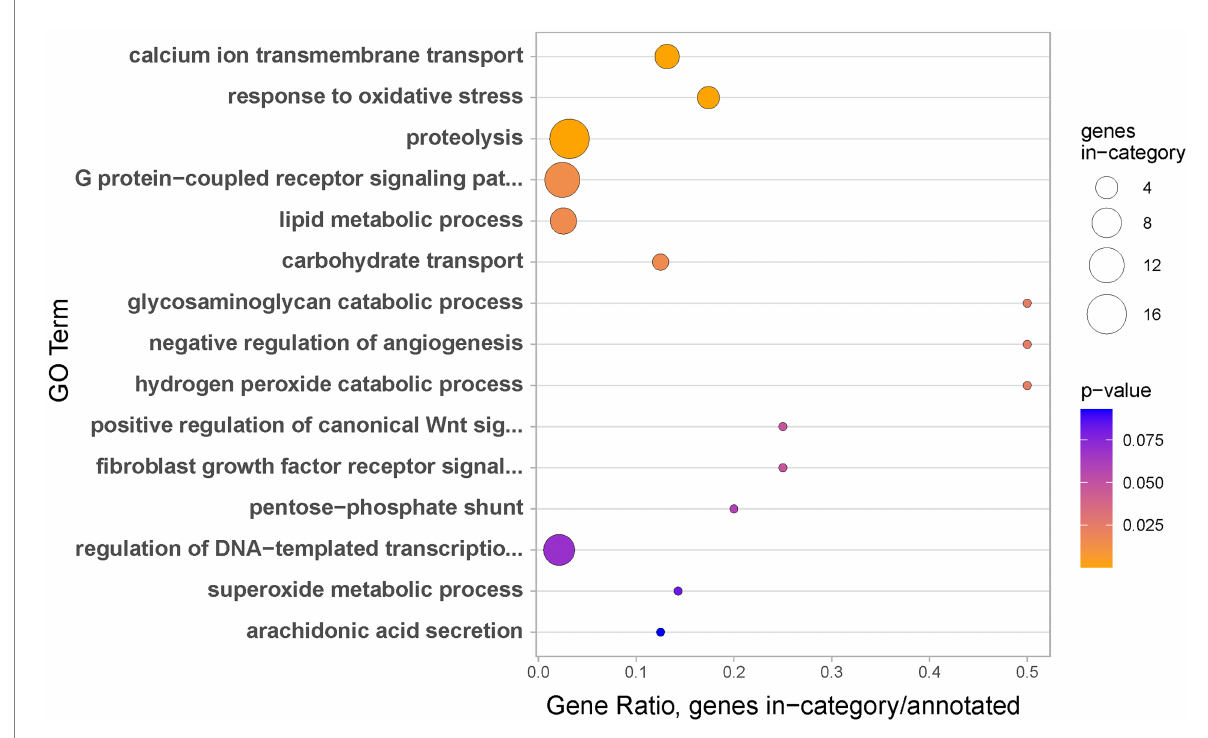
FIGURE 7 Biological processes identified as gene ontology enriched terms in significantly upregulated genes in coenosarc edge samples in comparison to